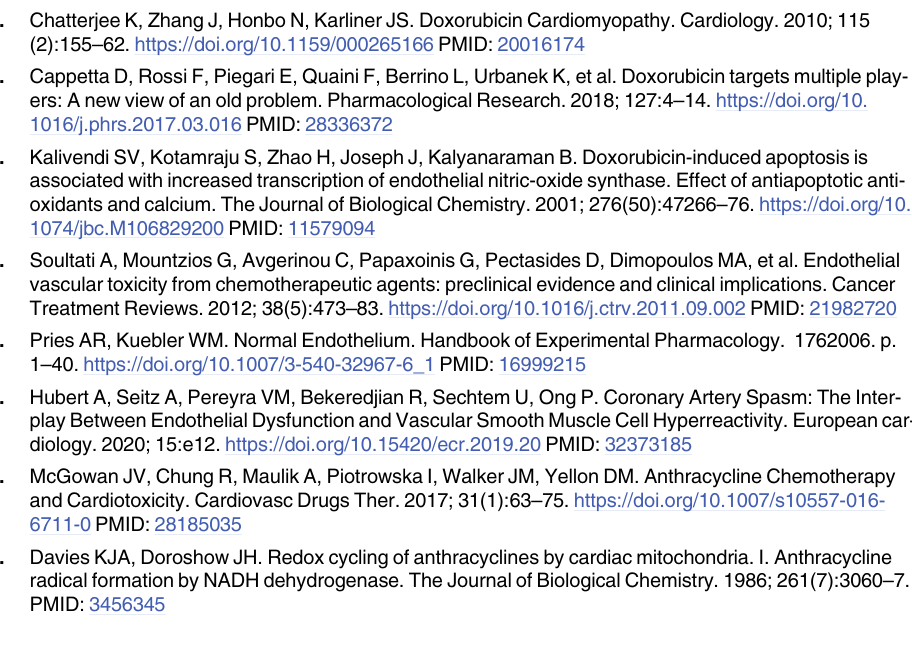
S1 Table. Key resources table. (PDF) S2 Table. Sequences of oligonucleotides used in this